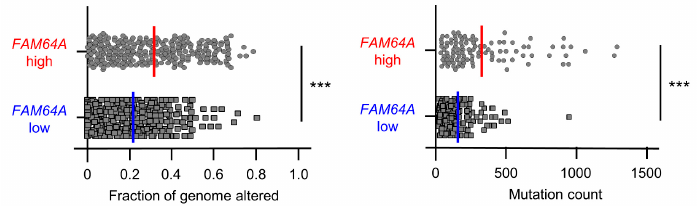
Figure 12. Associations of genome alterations and mutation counts with FAM64A expression in LUAD clinical specimens. Proportion of genome alterations (percentage of chromosome regions with copy number alterations relative to all regions evaluated; ( left )) and the mutation count (number of mutational events per case; ( right )) were significantly increased in the high compared with the low FAM64A expression group (*** p < 0.001).